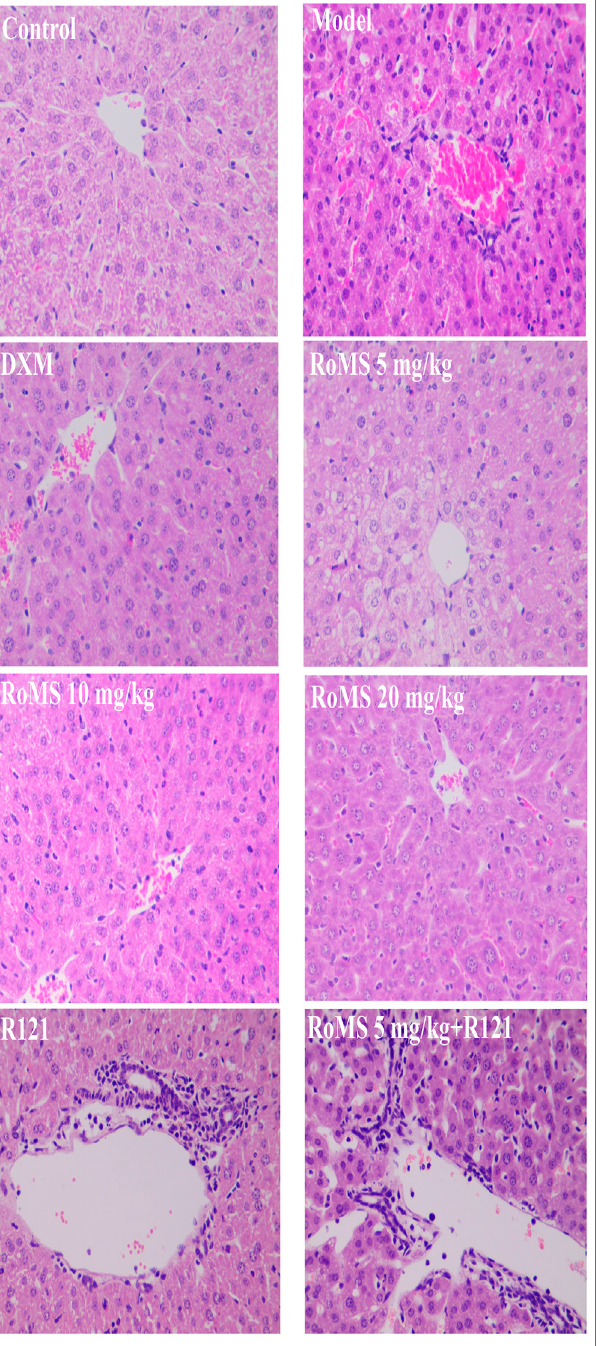
Frontiers in Pharmacology |